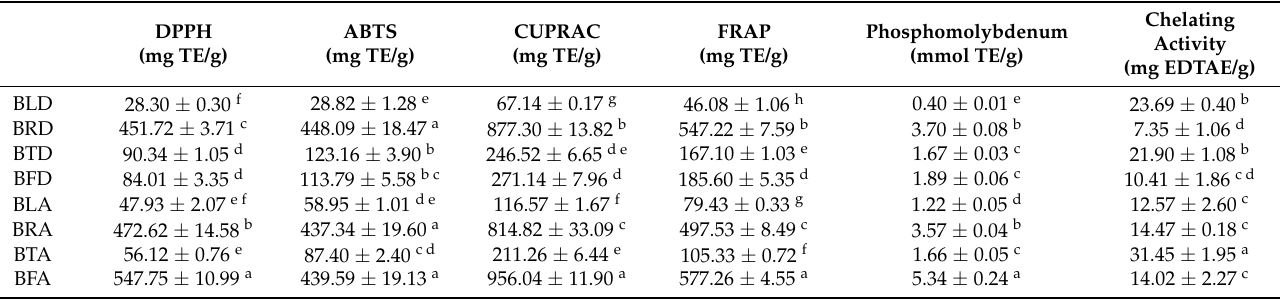
Table 6. Antioxidant properties of B. gymnorhiza